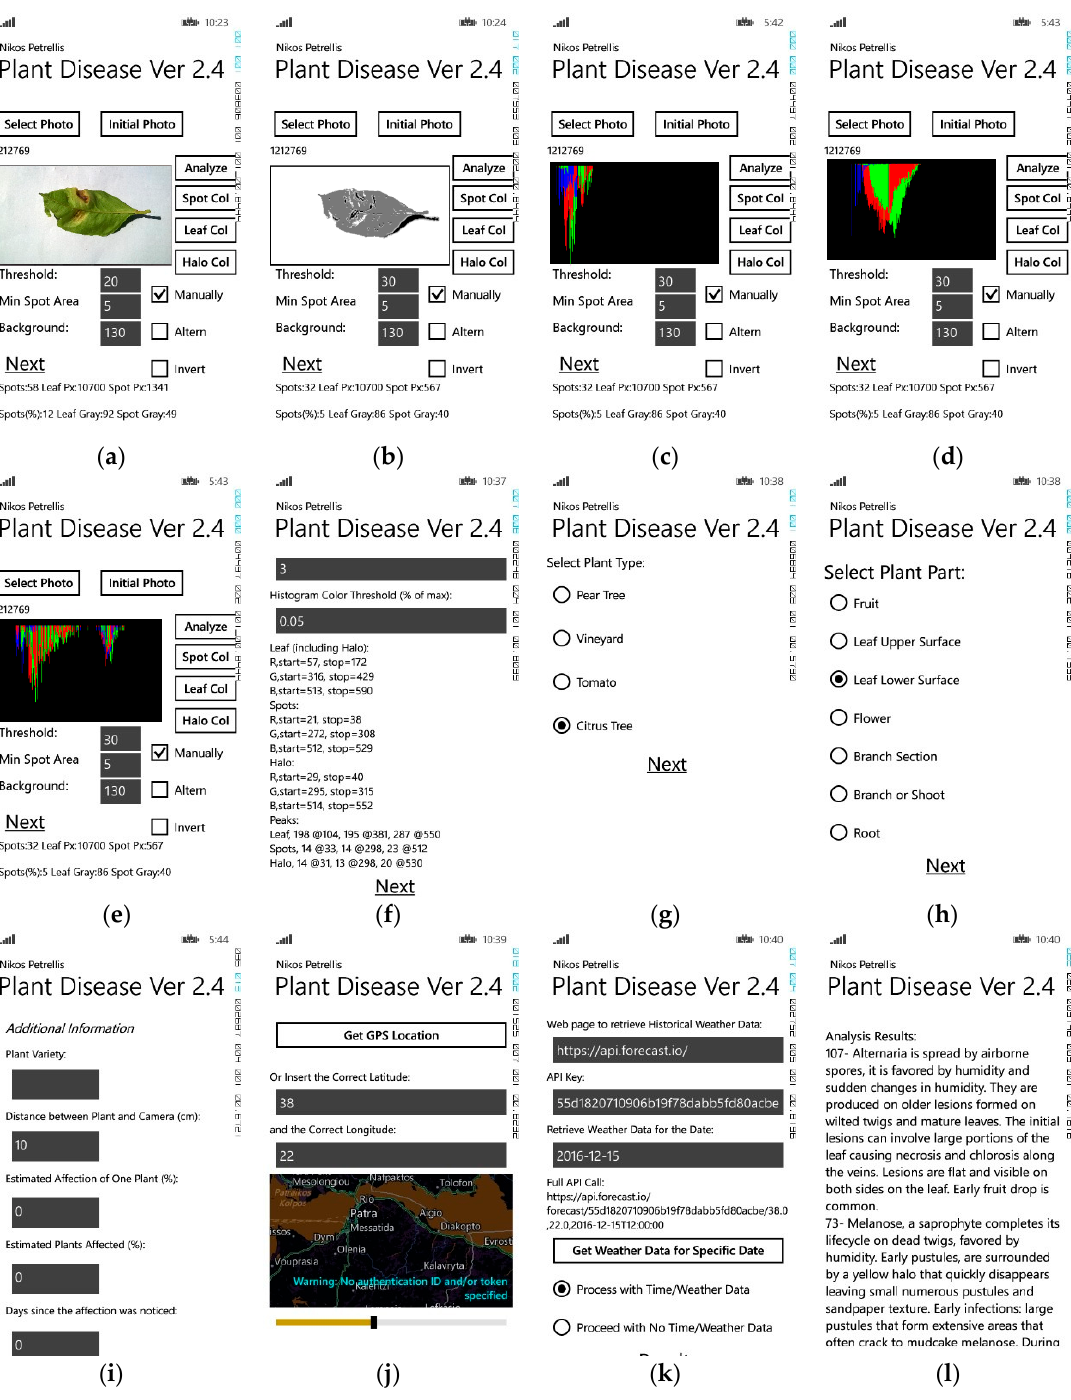
Figure 6. Application pages. The main page before image analysis ( a ), the main page after image analysis ( b ), spot histograms ( c ), leaf histograms ( d ), halo histograms ( e ), histogram feature extraction results ( f ), selection of the plant ( g ) and the plant part ( h ), additional information ( i ), geolocation ( j ), retrieval of weather data ( k ) and disease classification results ( l ).